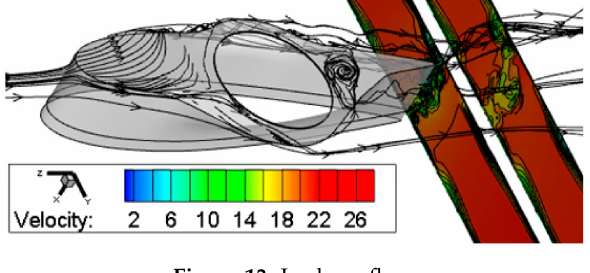
Figure 13. Leakage